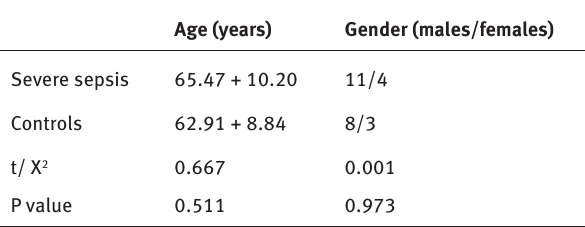
Table 1: Demographics of severe sepsis patients and controls